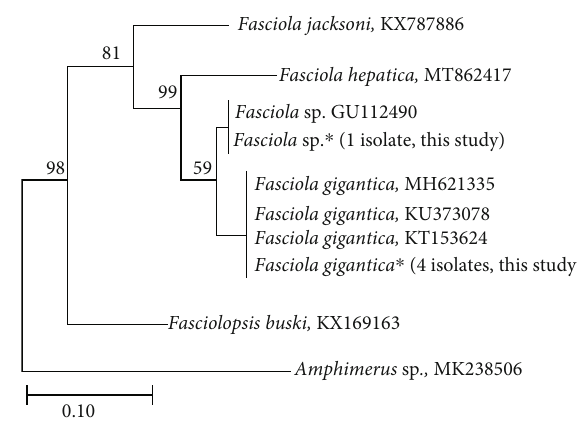
Figure 2: Phylogenetic tree of Fasciola spp. inferred from cox1 gene sequences reconstructed using the maximum likelihood (ML) method. Bootstrap values are shown on the nodes. The scale bar represents 0.10%